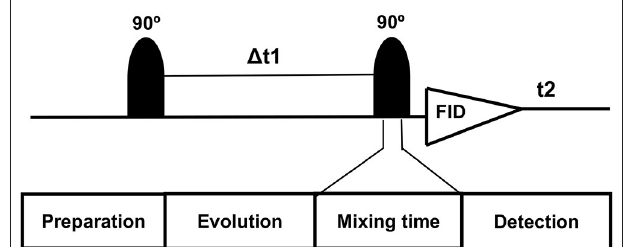
FIGURE 2 | Basic pulse diagram of a 2D-NMR experiment preparation time allows the nuclei in the sample to reach equilibrium with the static external magnetic field environment and solvent suppression is performed. During the evolution period, the magnetization of spins evolves. This time domain is incremented during the 2D-NMR experiment. During mixing time, coherence transfer takes place between J-coupled spins. During the detection period, transverse magnetization is